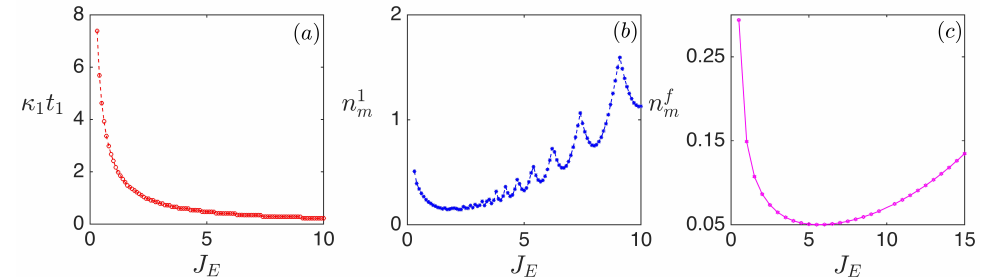
Figure 4. Corresponding relations between the three figures of merit with the effective coupling intensity J E in the scenario of one pulsed drive to the left cavity plus one CW drive to the right